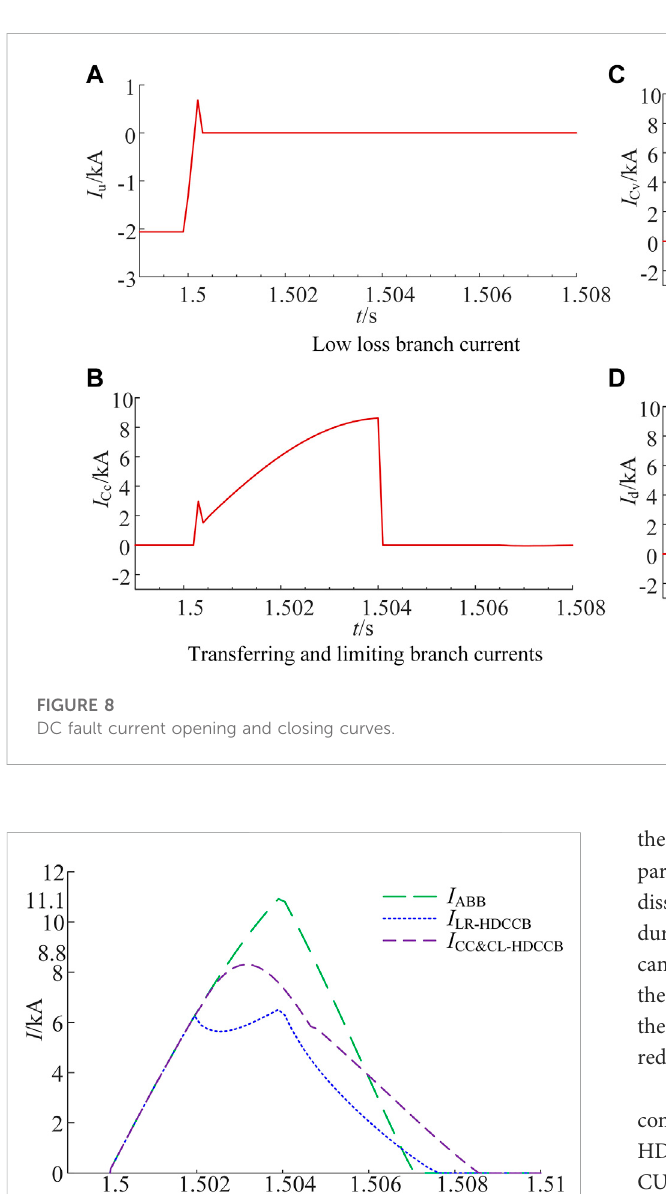
FIGURE 9 Fault current